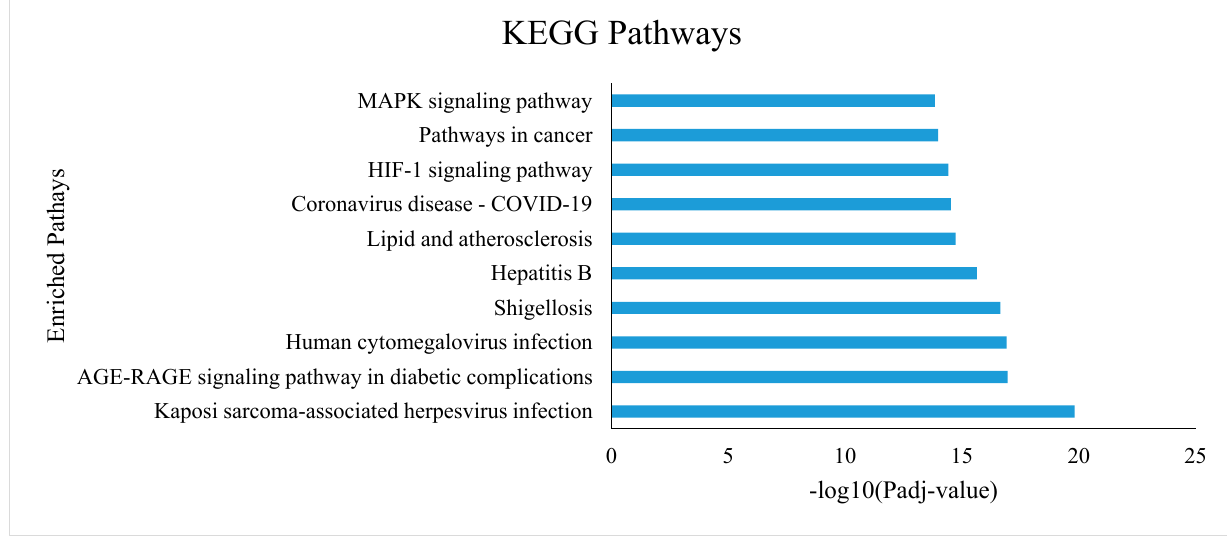
Figure 3. The KEGG pathways enriched by the proposed hHub-DEGs.